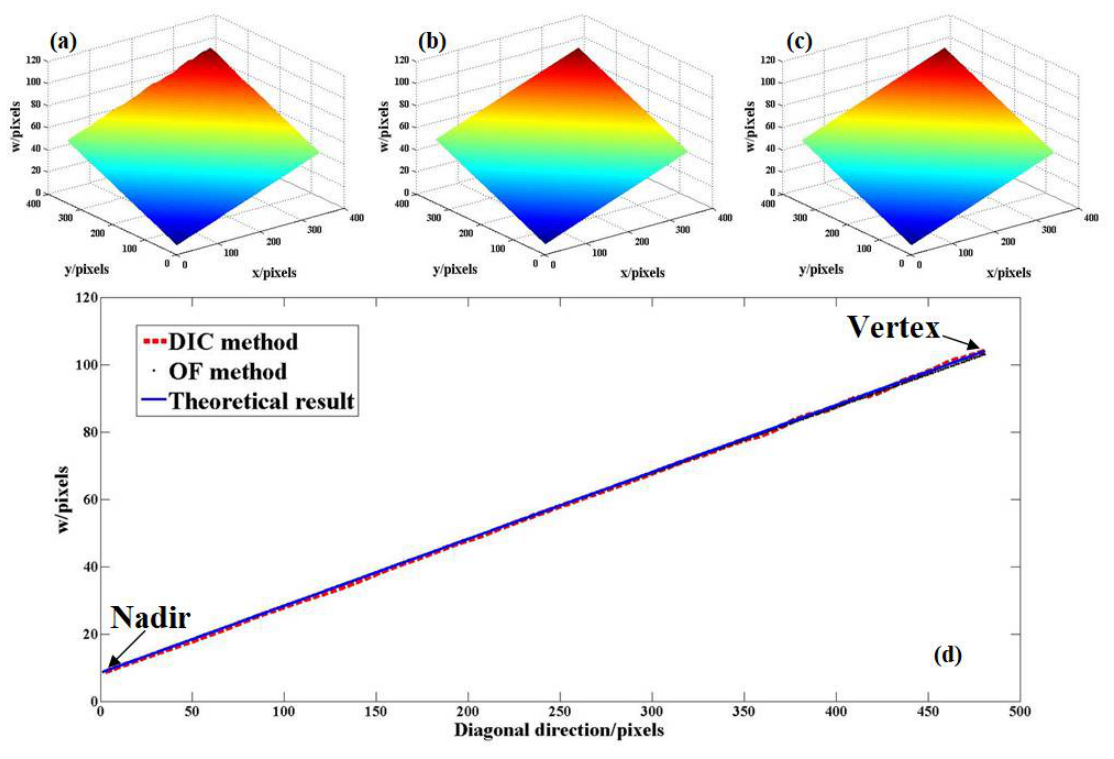
Figure 7. Out-of-plane displacement results of simulation experiment: ( a ) field w (DIC method); ( b ) field w (OF method); ( c ) field w (Theoretical result); ( d ) data of Figure 7a–c in diagonal direction. Table 1. Data of vertex and nadir in Figure 7d.